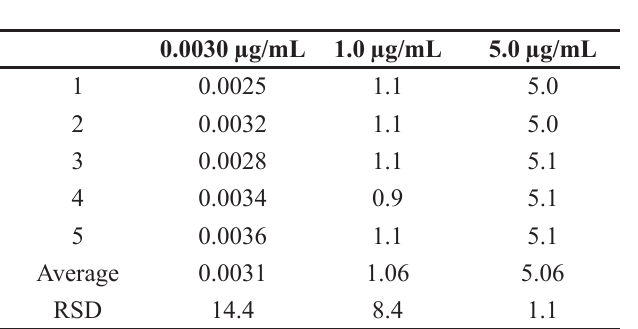
FIGURE 3 - Mean plasma volunteers